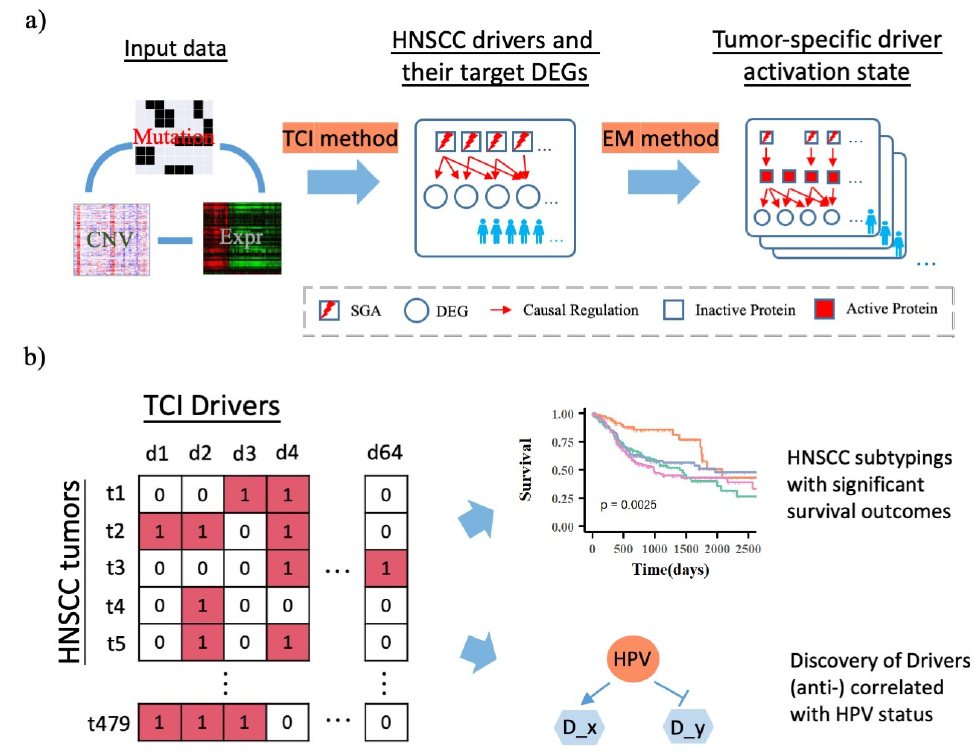
Figure 1. Workflow of the driver activation state inference, pathway analysis, subtyping and sur- vival analysis, and driver-HPV status association analysis for HNSCC patients. ( a ). Integration of multi-omics data types to infer driver activation state inference using TCI method and EM method. Mutations and CNV data are combined into SGA data and expression data are transformed to DEG data, which are used as the input of the TCI model. TCI calculates casual relationships between SGAs and DEGs for each individual patient, and we further generalize the most statistically significant causal SGA → DEG interactions in TCGA HNSCC patient cohort. Based on TCI inferred SGA → DEG causal relationship and selected DEG expression profile, EM algorithm is used to infer protein activation states for each HNSCC patient. ( b ). HNSCC patients can be divided into four subtypes based on 64 driver activation state and their survival outcome are significantly different among these patient subtypes. Our analysis also shows the viral driver proteins can be triggered by HPV status and regulate its downstream gene expression.